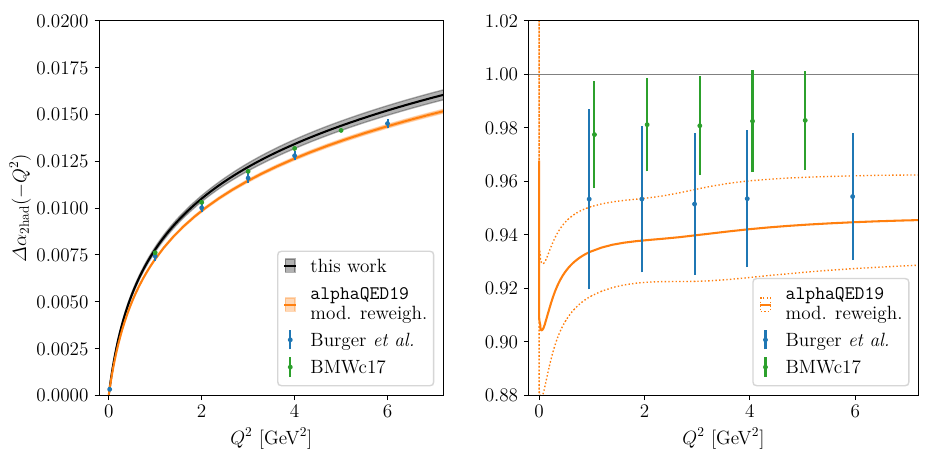
Figure 15 . Left: hadronic contributions to the running of the weak coupling α 2 from the our computation, compared to lattice results from ref. [19], as well as the phenomenological estimate determined using alphaQEDc19 [13, 134], as a function of the space-like momentum transfer Q 2 . Right: ratios of the phenomenological estimate and of the lattice computation in ref. [19] over our